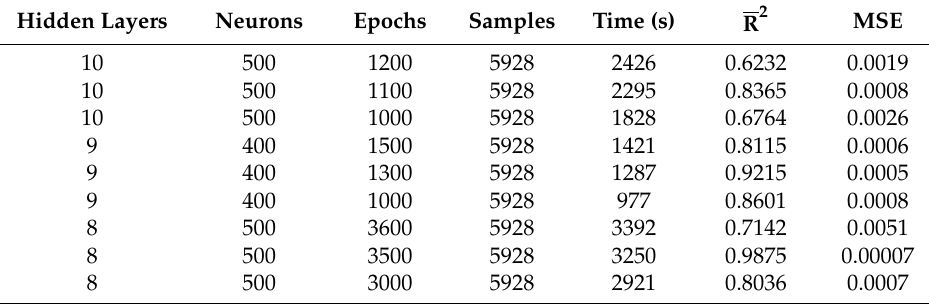
Table 4. Parameters and Results of Model